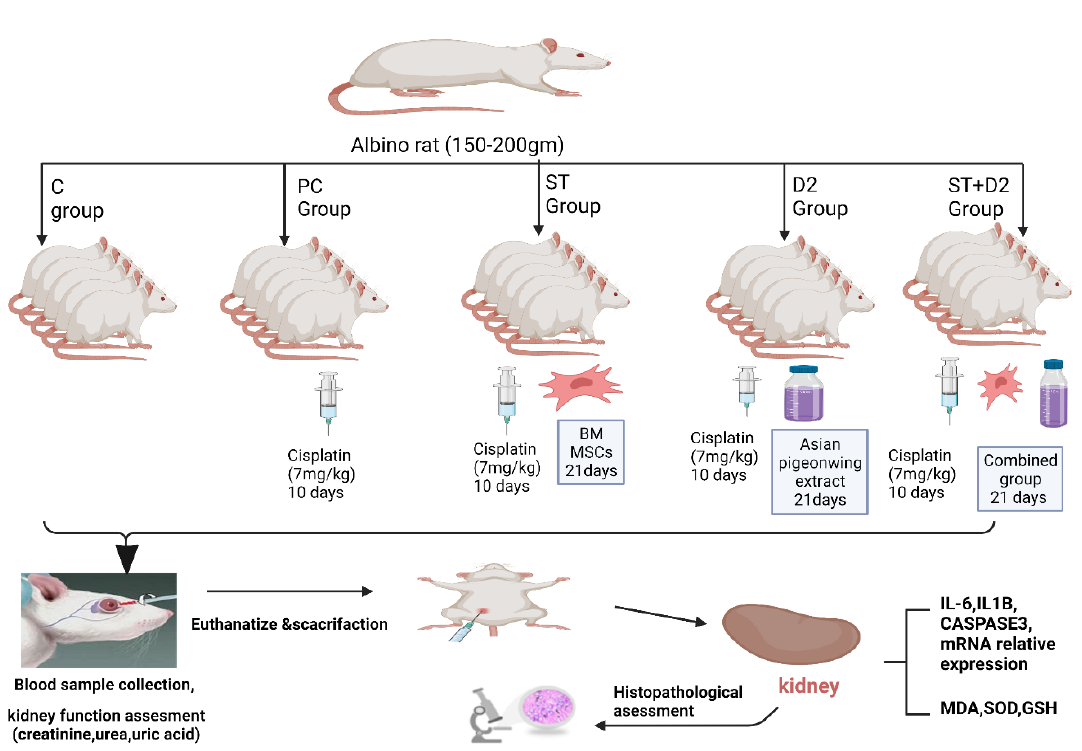
Figure 5. Summary of the animal model and the experimental design. Treatments were carried out for 21 consecutive days with BM-MSCs and/or Asian pigeonwing before the animals were